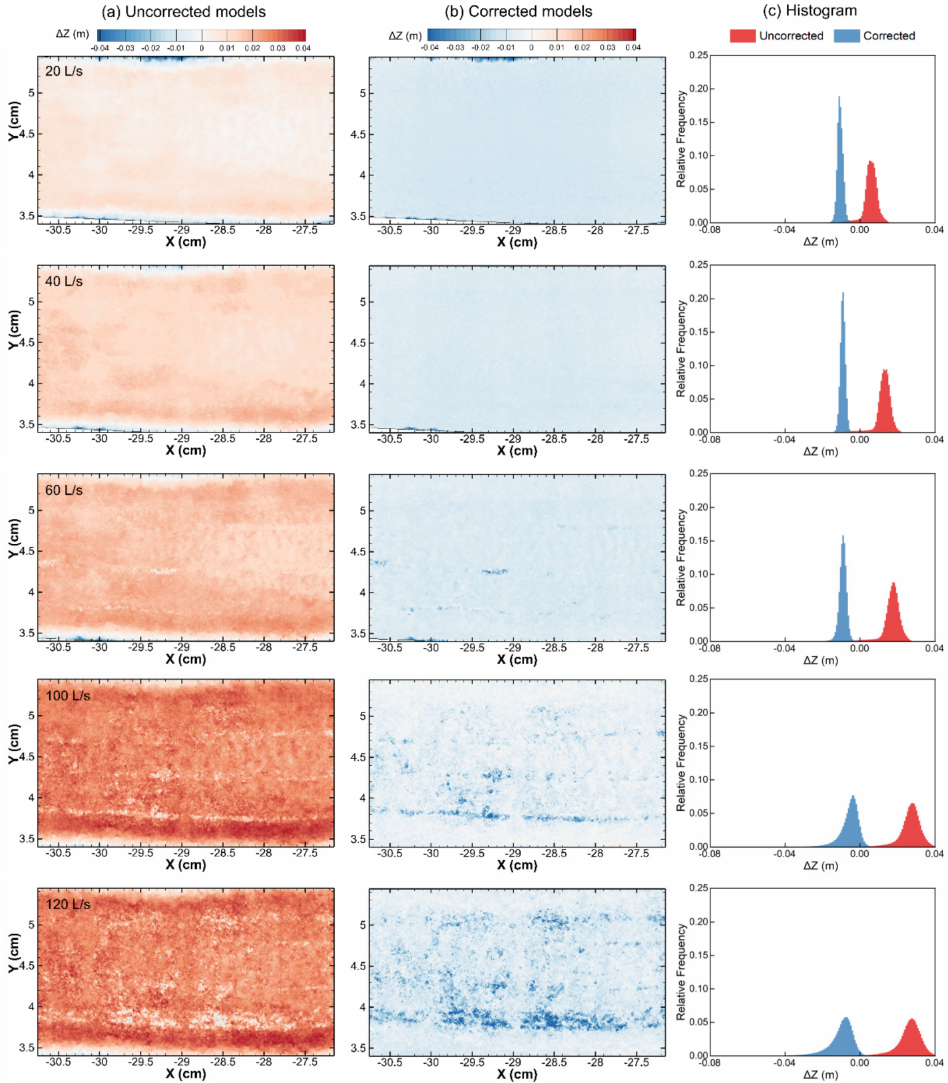
Figure 5. The contours and histograms of elevation errors for the through-water SfM models using the bank GCPs for MR1: ( a ) uncorrected models; ( b ) corrected models; ( c ) histograms. Flow goes from the left to the